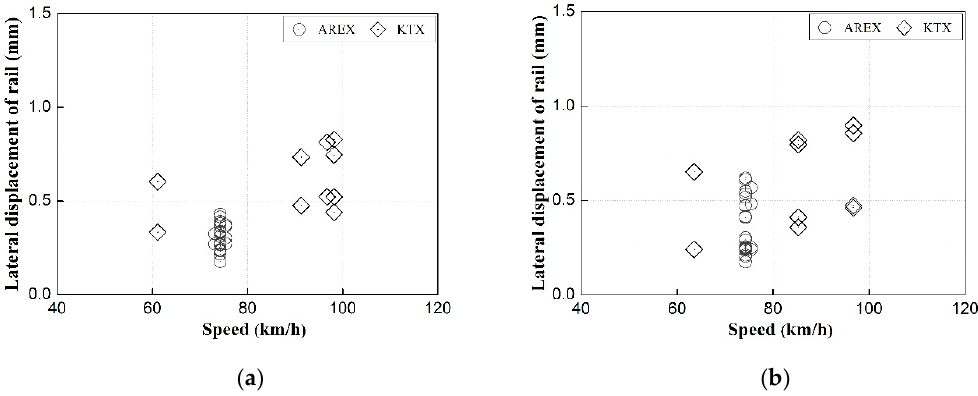
Figure 9. Measured displacement of the track girder by train type. ( a ) Before rail pad replacement and ( b ) after rail pad replacement.